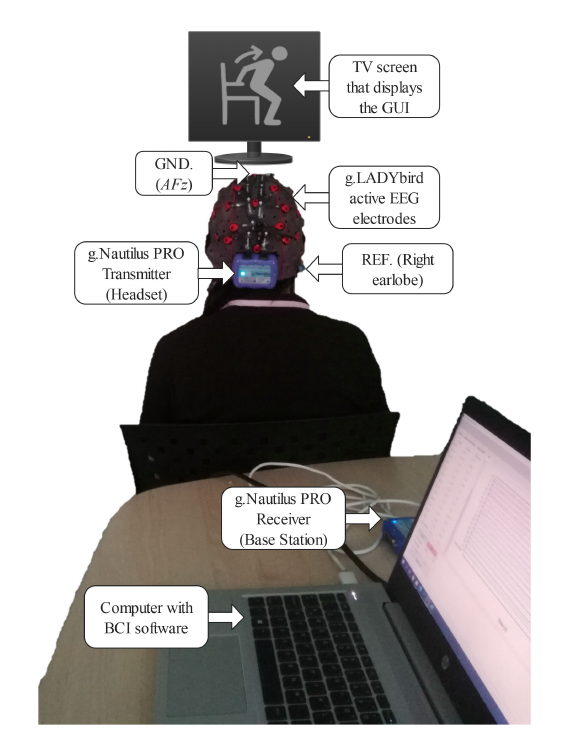
FIGURE1 Experimental setup with a participant in front of the TV screen with the graphical user interface (GUI) to present visual cues regarding each step in the sequence of a trial. The participant is equipped with a g.Nautilus PRO system with 17 gel-based active electrodes (g.LADYbird technology) to acquire the electroencephalogram (EEG) and transmit it wirelessly from the headset (transmitter) to the receiver (base station) connected to the computer with the BCI software. REF, reference electrode; GND, ground electrode at AFz